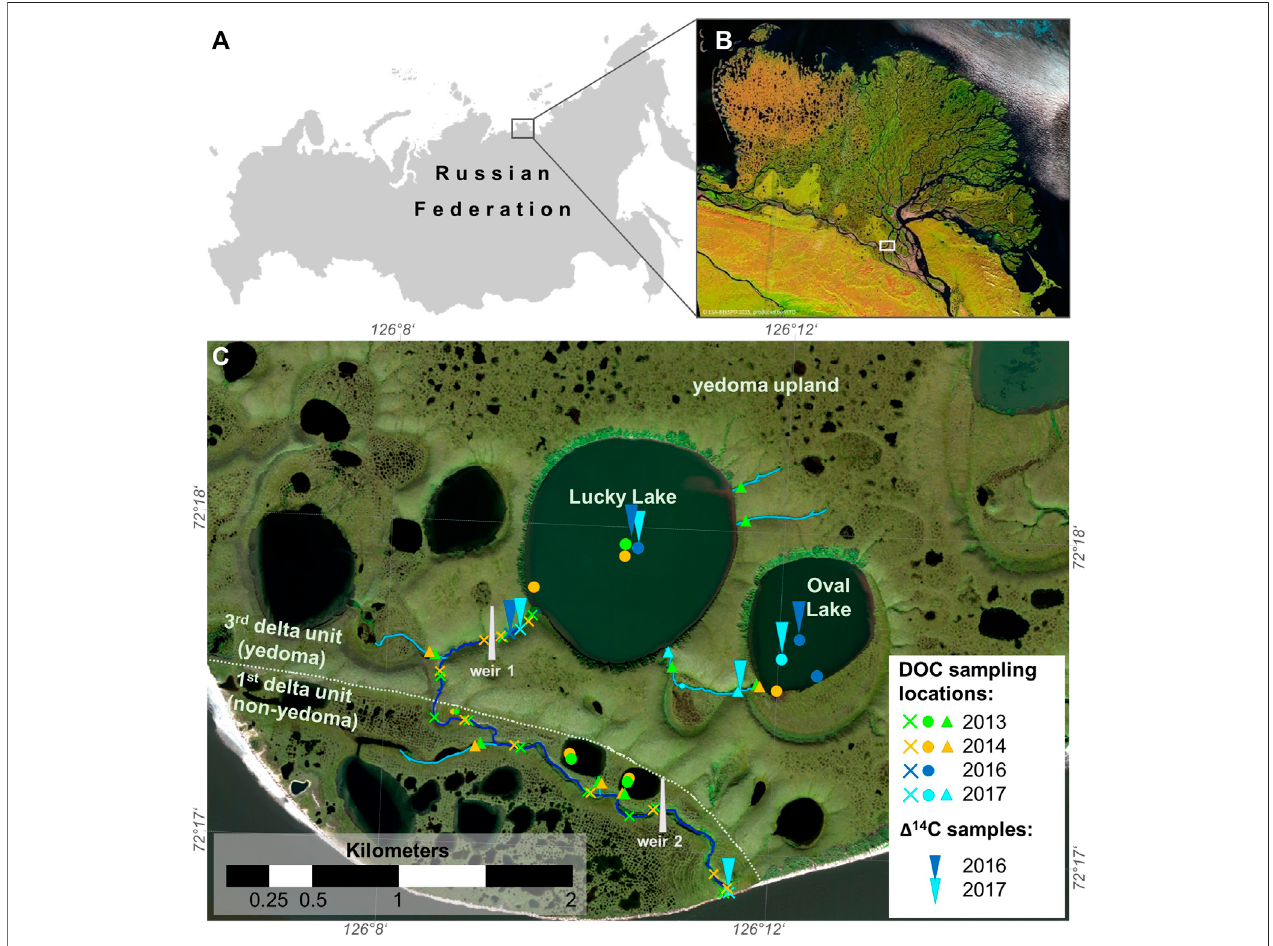
FIGURE1| Overviewandsamplinglocationsinthestudysitein (A) NortheasternSiberia(map:ESRI)inthe (B) LenaRiverDelta(ESAProbaVITOLenaRiverDelta). The high resolution satellite image shows (C) DOC and 14 C sampling locations for lakes and ponds (circles), Lucky Lake stream (crosses), and in fl ows (triangles) in the south ofKurungnakhIsland. LuckyLake stream totheOlenyokskayaChannel ishighlighted indarkblue and in fl owsarehighlightedinlightblue (WorldView2image from 2015, copyright by DigitalGlobe).